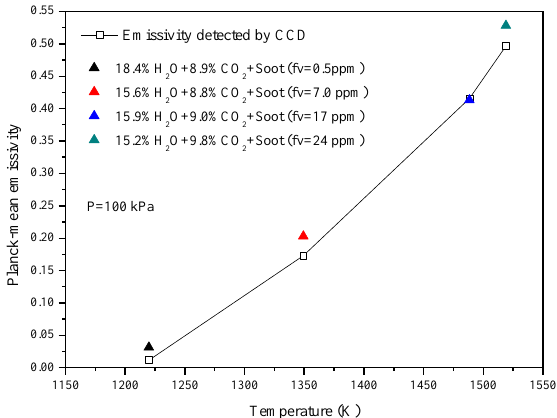
Figure 14. The Planck-mean emissivity of combustion products in the visible spectral bands.